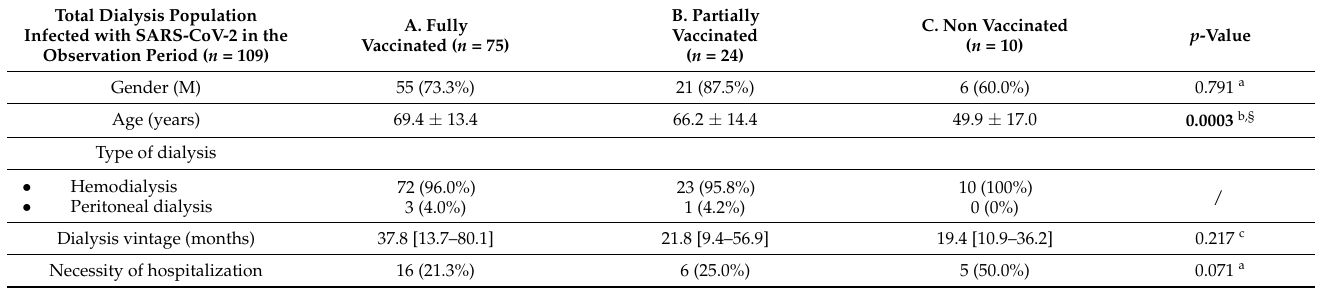
Table 3. Comparison of demographic, clinical and COVID-related variables in dialysis patients infected during the 4-mont period (from November 2021 to February 2022), grouped according to the vaccination status. Continuous variables are presented as means ± standard deviation (SD) in normally distributed and as median with interquartile range (IQR) in square brackets if non-normally distributed, and nominal variables are presented as percentage and absolute numbers in brackets. Significant p -values are in